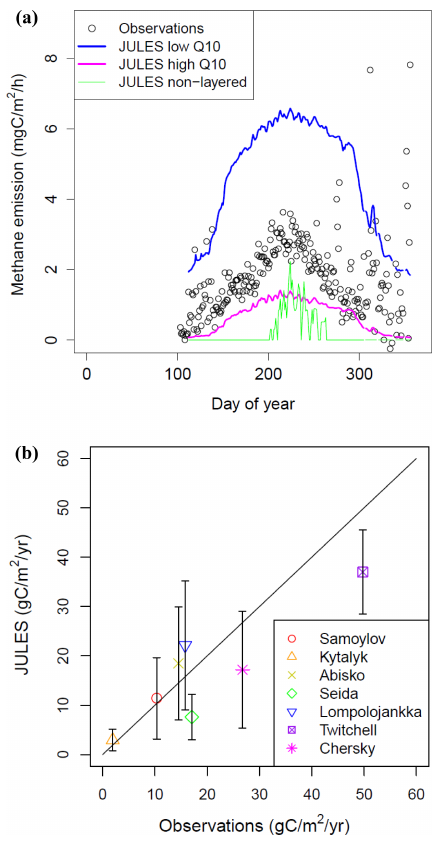
Figure 2. (a) Observed (circles) and modelled wetland methane emissions at the Samoylov Island field site. Modelled wetland methane emissions are shown for the standard JULES non-layered soil carbon configuration (green) and for the JULES layered soil carbon configurations with low (blue line) and high (magenta line) Q 10 temperature sensitivities; the low Q 10 configuration gives higher methane emissions at high-latitude sites such as the Samoylov Island field site. The methane emission data are prelimi- nary and were provided by Lars Kutzbach and David Holl. (b) Com- parison of observed and modelled annual mean wetland CH 4 emis- sion fluxes at a number of northern high-latitude and temperate sites. The error bars denote the lower and upper estimates from the low and high Q 10 simulations. The symbols represent the mean value between these